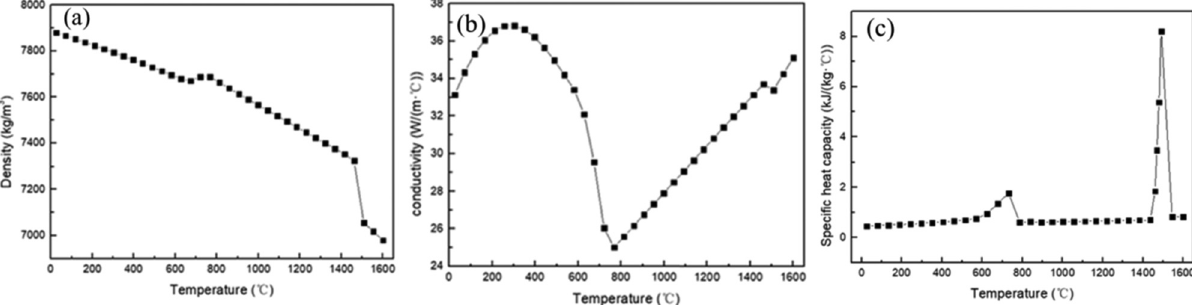
Figure 1: Variation of thermophysical parameters of 30Cr2Ni4MoV steel with temperature: ( a ) density; ( b ) thermal conductivity; ( c ) speci fi c heat capacity.